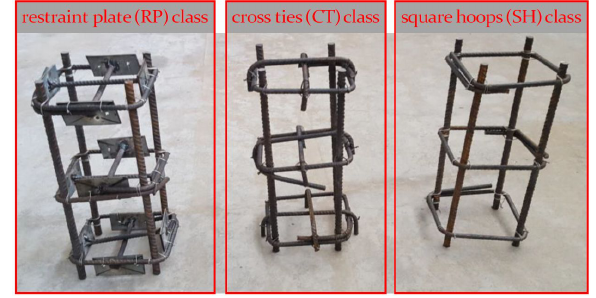
Figure 2: Different arrangements of transverse reinforcement con- sidered in this experimental campaign: RP class (left), CT class (center), SH class